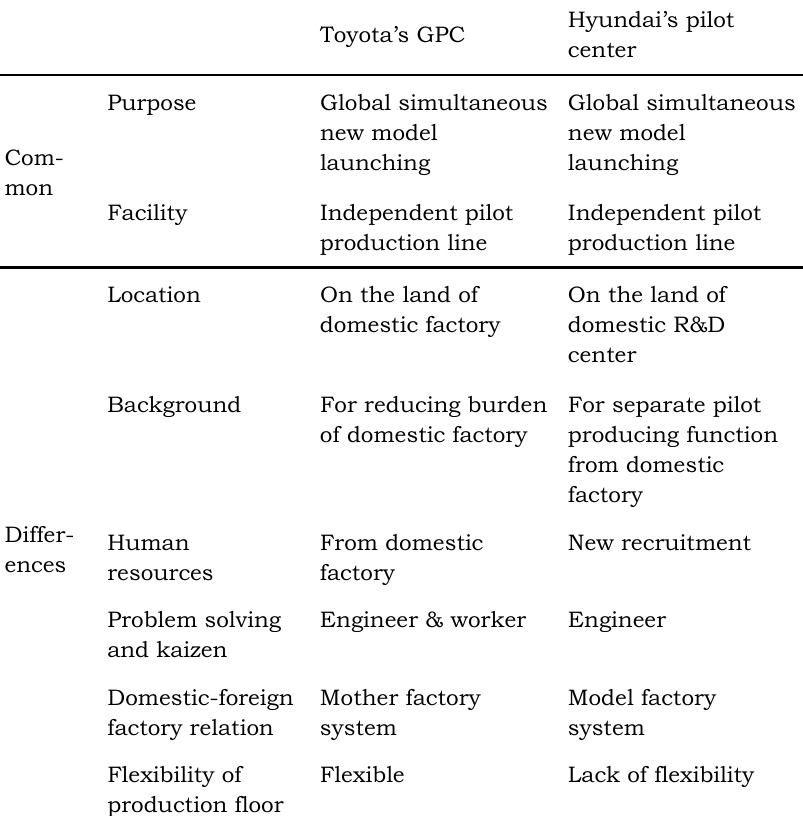
Table 1. GPC and pilot